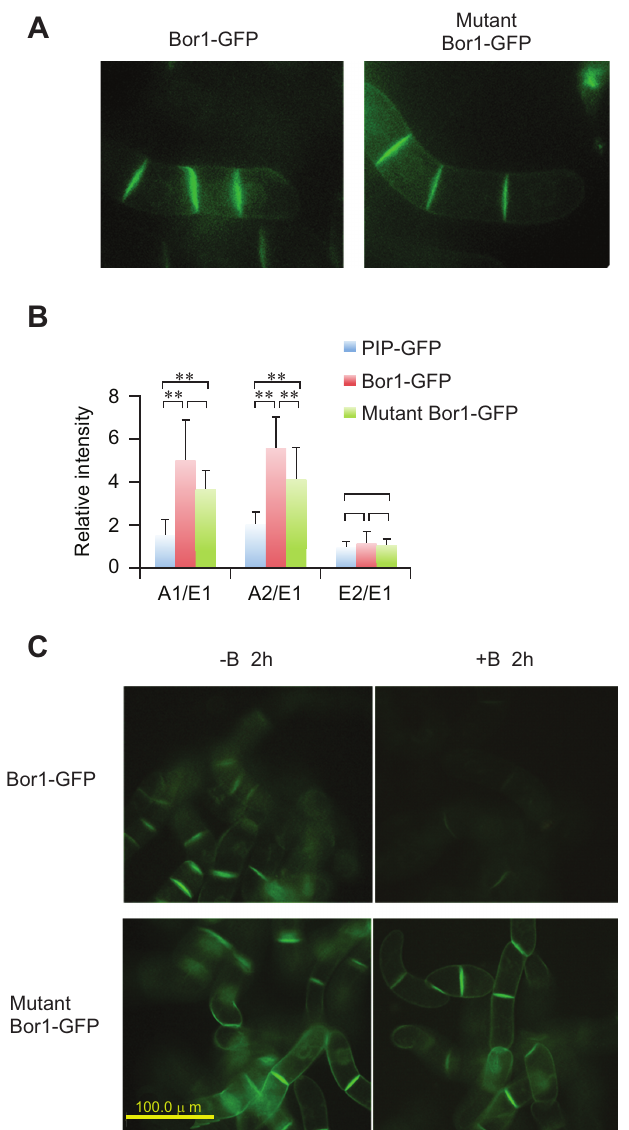
Figure 8. Expression of Tyr mutant of BOR1-GFP. A . Confocal images of 4-cell stage tobacco cells expressing wild-type and mutant BOR1-GFP. B . Comparison of the relative density of fluorescence at each face of the cells expressing either PIP-GFP, wild-type BOR1- GFP or mutant BOR1-GFP. Mean densities relative to the E1 face (n=8) are shown. Error bars, SD. ** represents significance at p<0.01. C . Mutant BOR1-GFP is stable in the presence of high- concentrations of borate. Epifluorescence images of cells incubated with normal (-B, 0.1 mM) or high borate (+B, 5 mM) for 2 h are